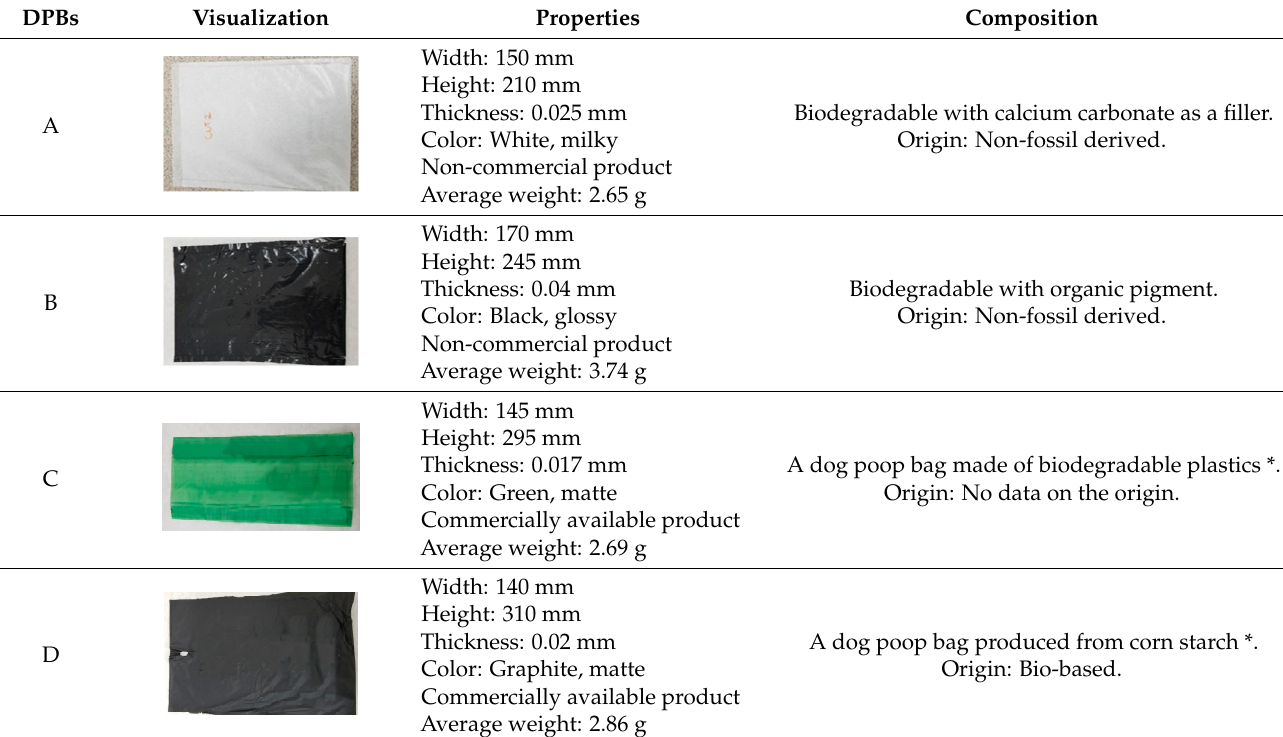
Table 2. Characteristics of the dog poop bags (DPB) used in the experiment.